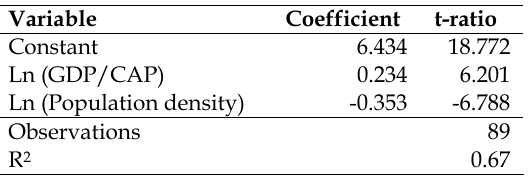
Table 4. City estimation results for passenger-kilometres